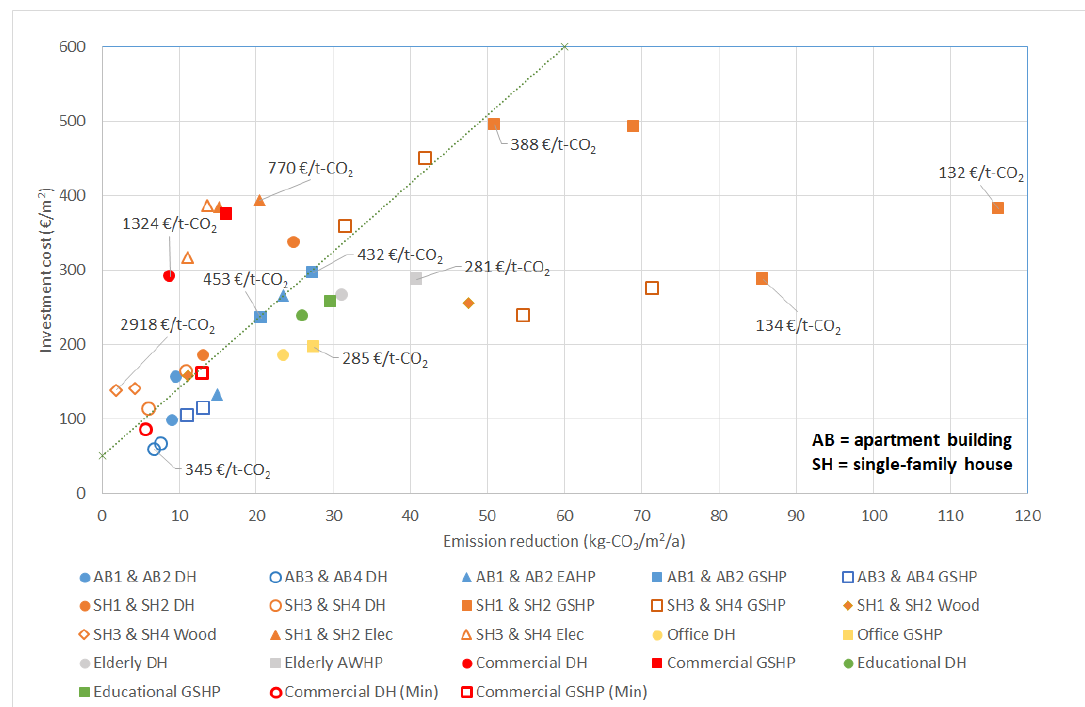
Figure 4. Investment cost for different levels of emission reduction. Different building types are identified by color, while the heating systems are identified by the shape of the symbol. The numbers next to some of the points are examples of emission reduction cost, i.e., what is the investment cost to reduce CO 2 emissions by one ton over 25 years.